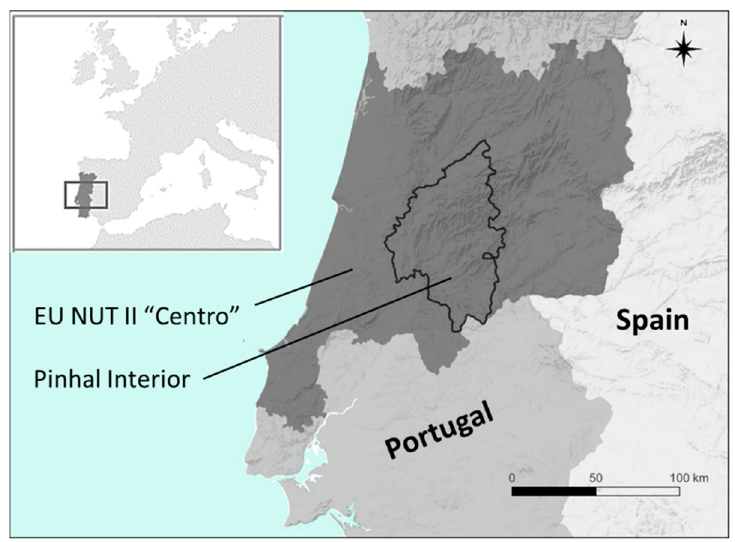
Figure 1. Location of the study area “Pinhal Interior” in the “Centro” region (EU-NUT II), Portu- gal.